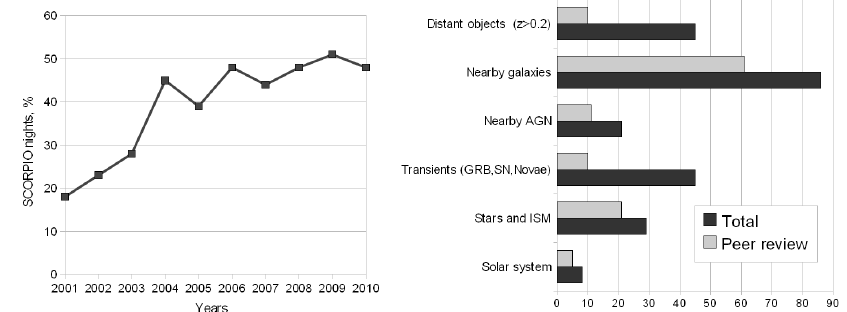
Fig. 1. The percentage of the calendar time distributed by the 6 m telescope Program Committee for the SCORPIO observations (left). Distribution of publications based on SCORPIO observations in 2001–2011 among different topics (right): the total amount (black) and peer-review journals only